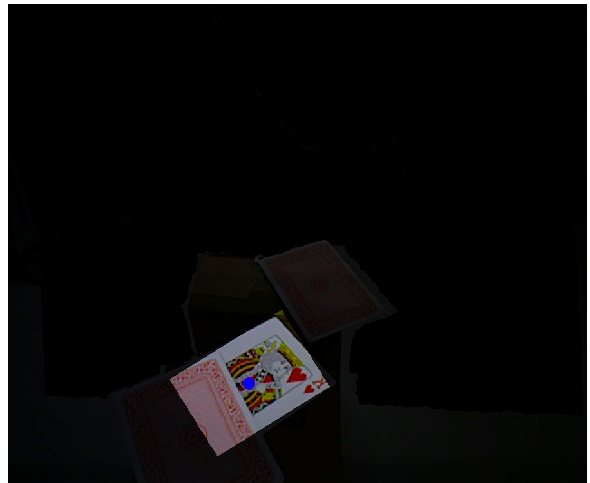
Figure 17. Successful pattern recognition.